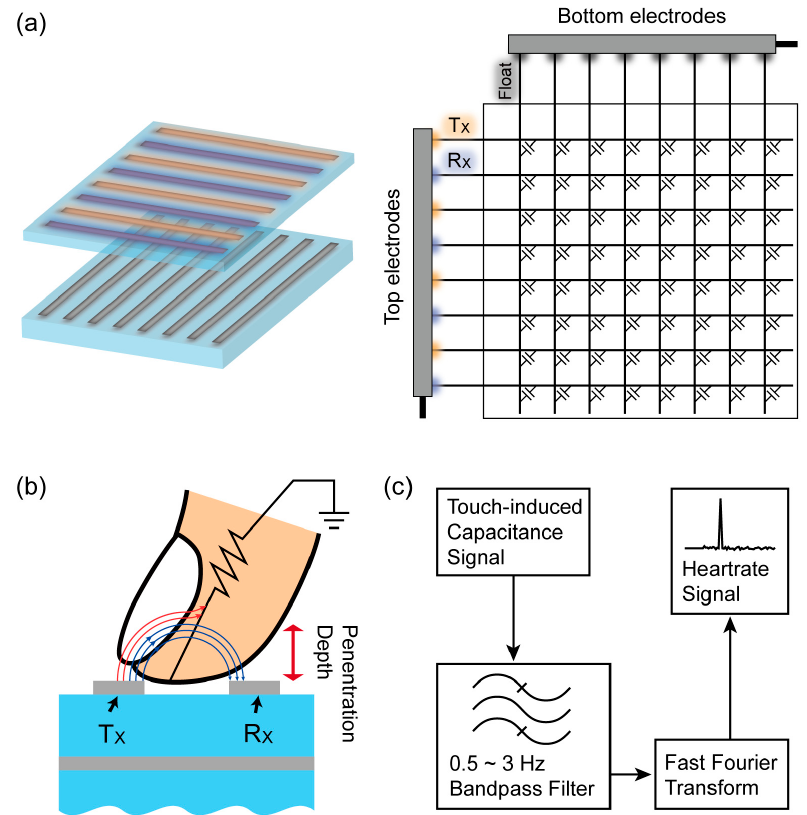
Figure 3. Schematic view of ( a ) electrode/circuit configuration and ( b ) the operational principle of TSP for heart-rate sensing mode. ( c ) Schematic diagram of signal processing flow to obtain the frequency spectrum of measured capacitance.